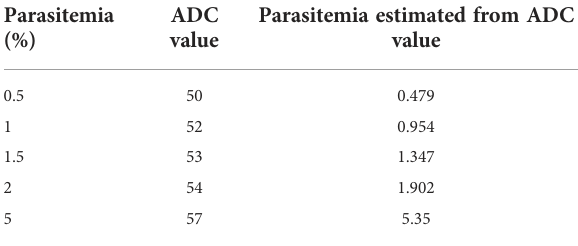
TABLE 2 Comparison of parasitemia estimated from ADC value with parasitemia determined by